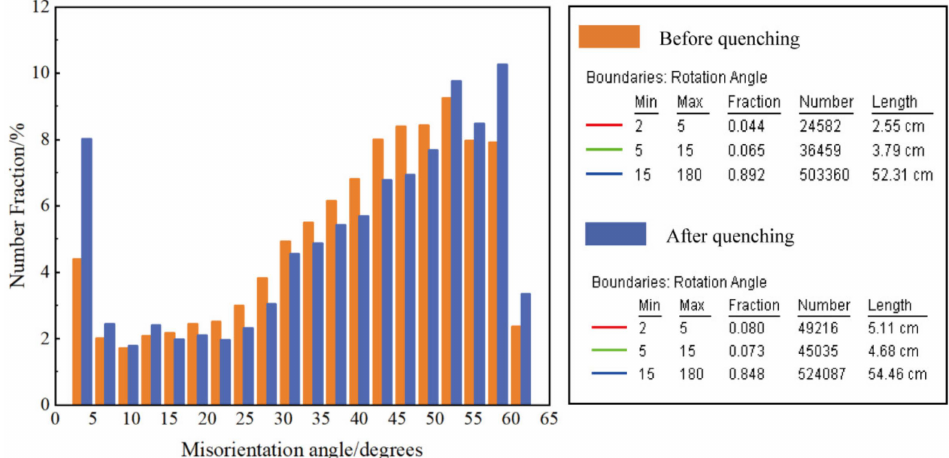
Figure 19. Statistics of the angle